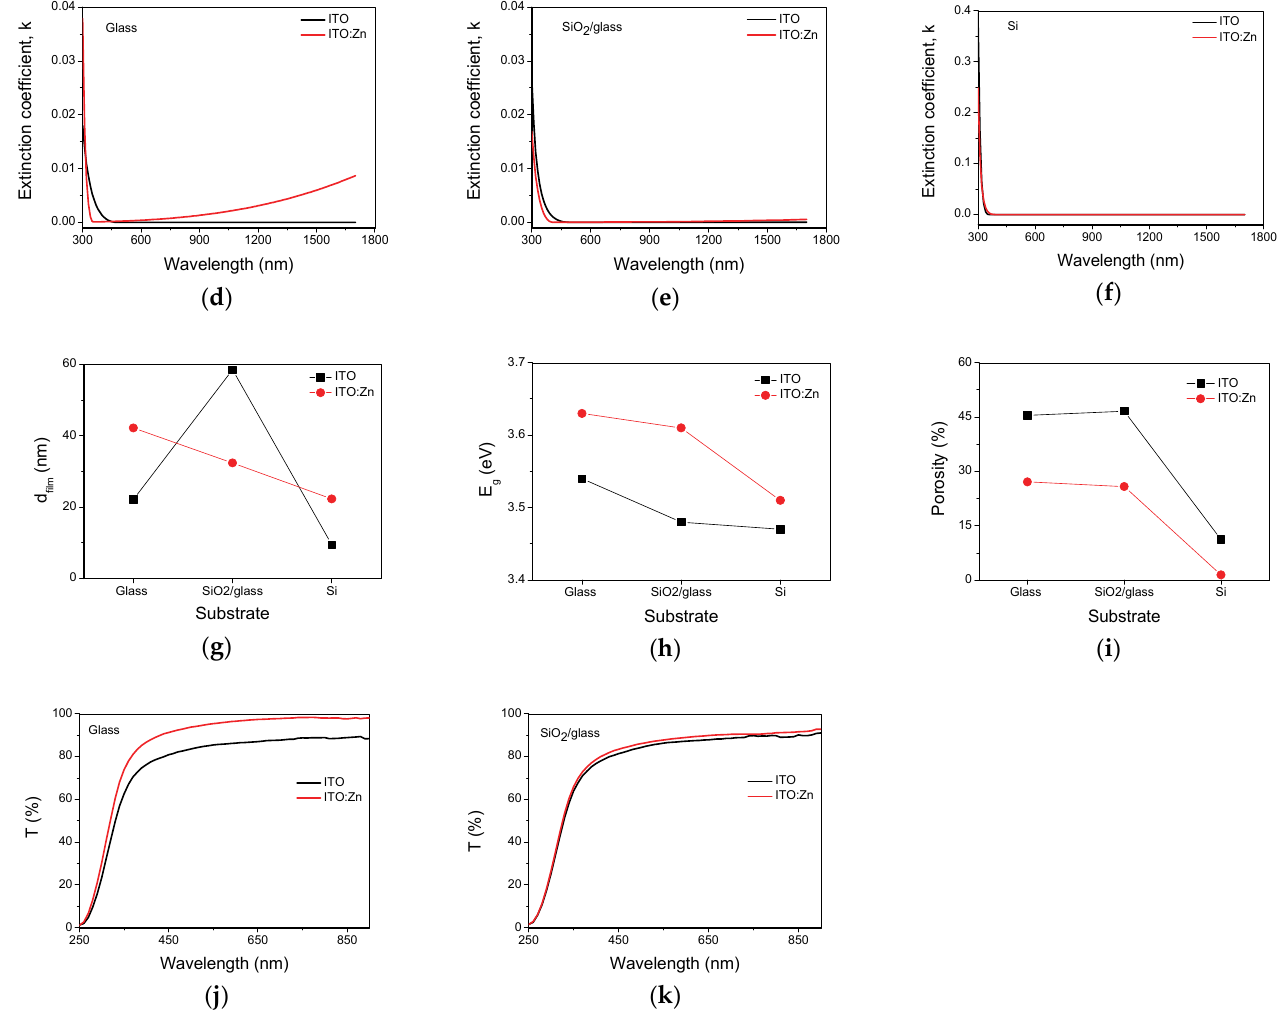
Figure 8. Optical constants—n, k ( a – f ), thickness—d ( g ), optical band gap—E g ( h ), porosity—P ( i ), and transmission—T ( j , k ) resulting from ellipsometric measurements and analysis of undoped and doped ITO thin films.